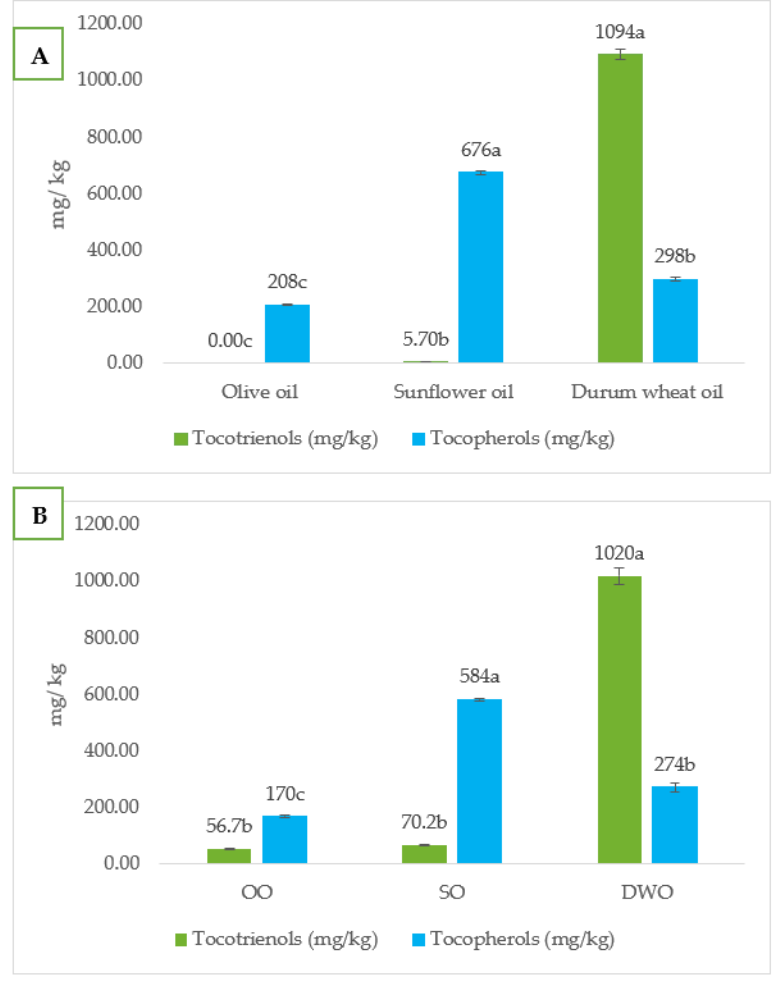
Figure 1. Tocopherols and tocotrienols content (mg/kg) of oil ( A ) and focaccia ( B ). SO = focaccia with sunflower oil; OO = focaccia with olive oil; DWO = focaccia with durum wheat oil. Data are presented as means ± SD of three replicates. Different letters in the same row indicate significant differences at p < 0.05.